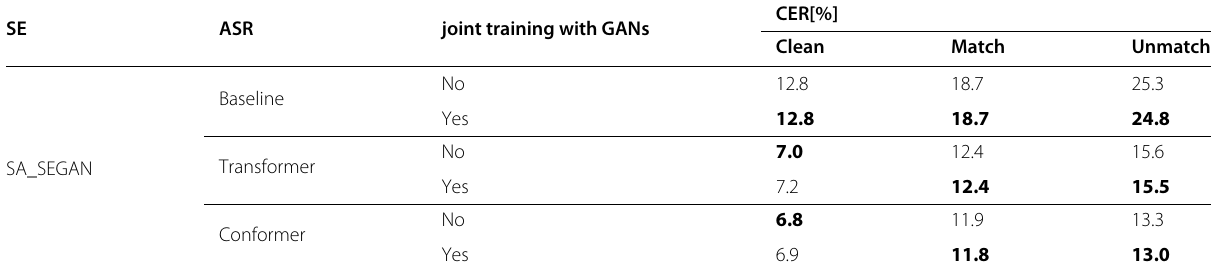
Table 5 The impacts of the joint training with and without GAN on SA-ASR pipeline. The results are in CER [%] SE ASR